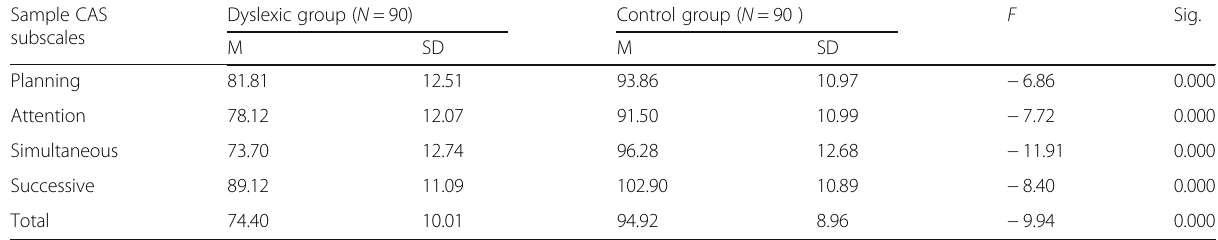
Table 3 Cognitive Assessment System: dyslexic vs. controls (total sample) Sample CAS Dyslexic group ( N = 90) Control group ( N = 90 ) F Sig. subscales M SD M